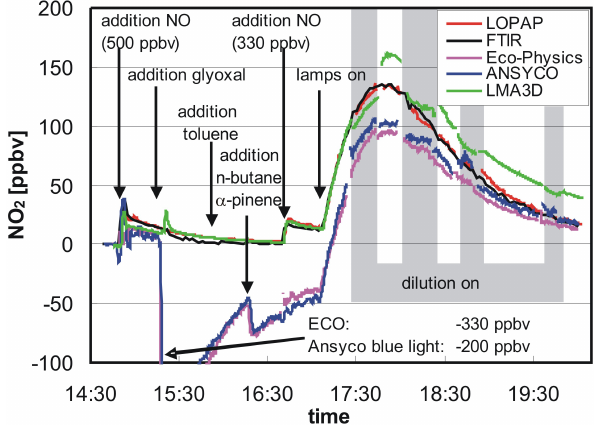
Fig. 4. Intercomparison of three commercial NO instruments and 2 the new NO -LOPAP instrument with FTIR spectrometry during 2 a complex photo-smog experiment. The grey shaded area indicate the periods, when the sample air of all the external instruments was diluted with synthetic air by factors of between 1.2–3.5, which was considered for the concentration